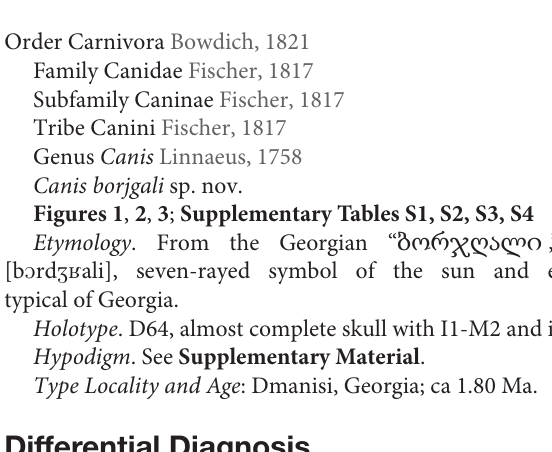
Frontiers in Earth Science |